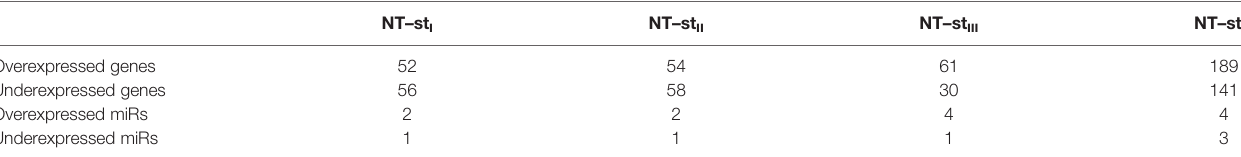
TABLE 4 | Unique differentially expressed genes and miRs for each non-tumor stage